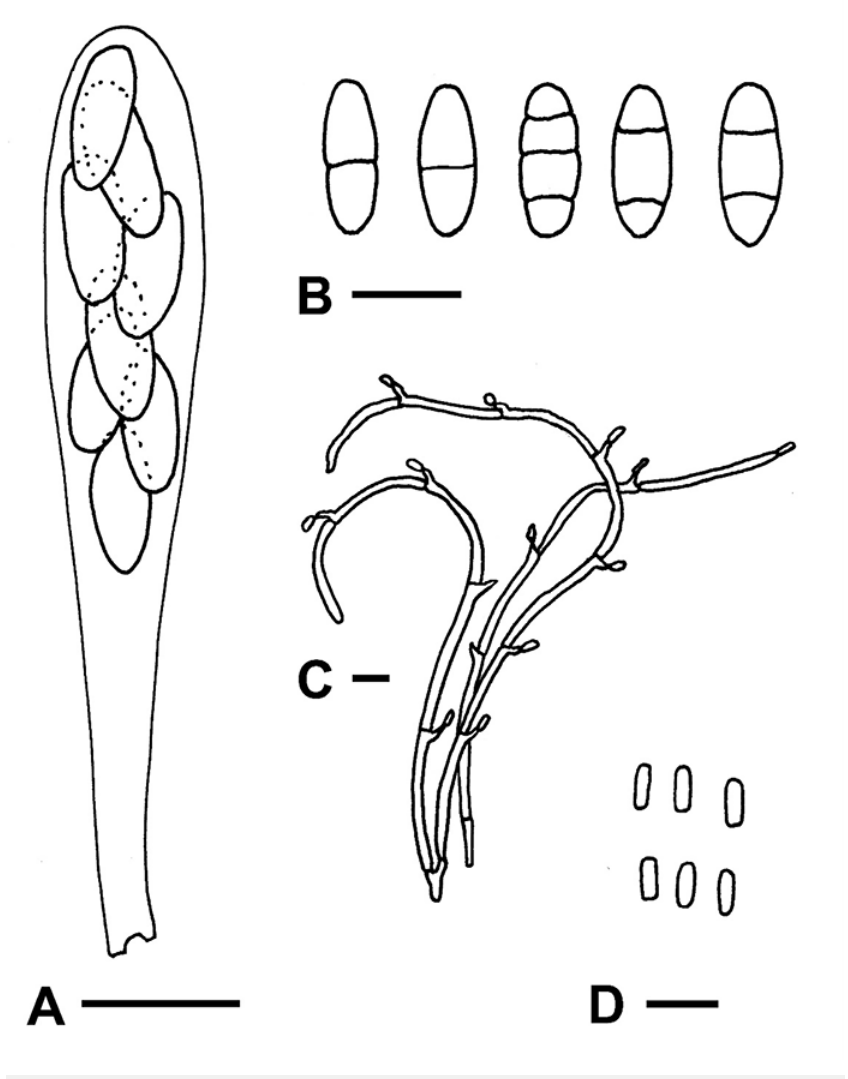
Figure 1 Microcharacters of Nectria nigrescens : ( A ) Ascus (with immature spores); ( B ) Ascospores; ( C ) Conidiophores; ( D ) Conidia. Scale bars: 10 μm. Drawing by B.